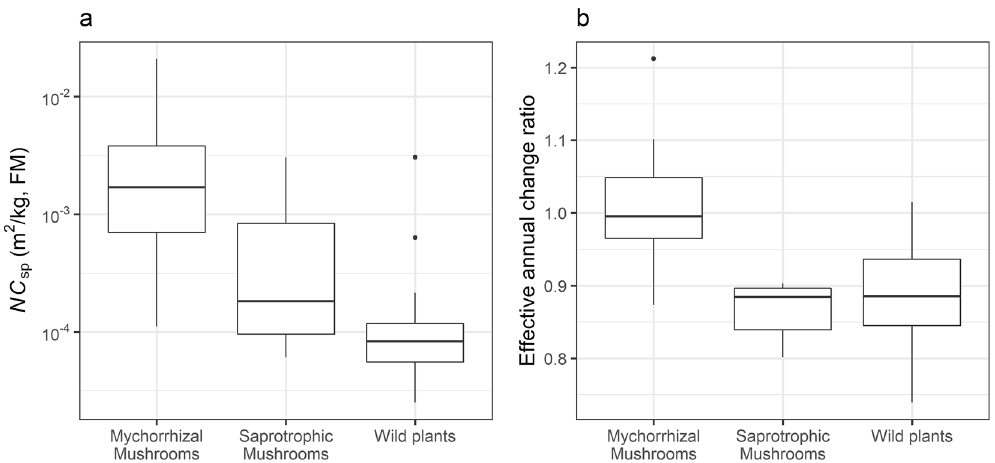
Figure 4. Boxplots of species’ concentration parameters according to type. ( a ) Normalized 137 Cs concentration of species ( NC sp , log scale) and ( b ) effective annual change ratio of 137 Cs concentration ( R eff_sp ). The unit for NC sp is m 2 /kg fresh matter (FM).